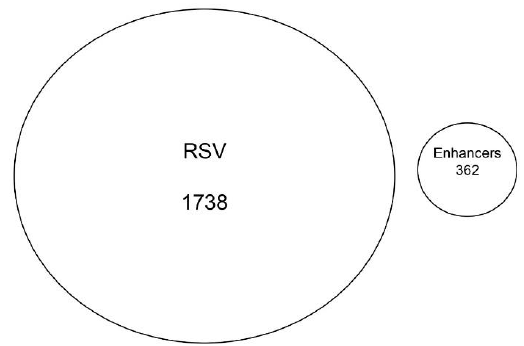
Figure 8. RSV-induced ATAC-Seq peaks are devoid of functional enhancers. Venn diagram of the overlap between the high confidence ATAC-Seq peaks from RSV-infected cells and active A549 enhancer sequences.